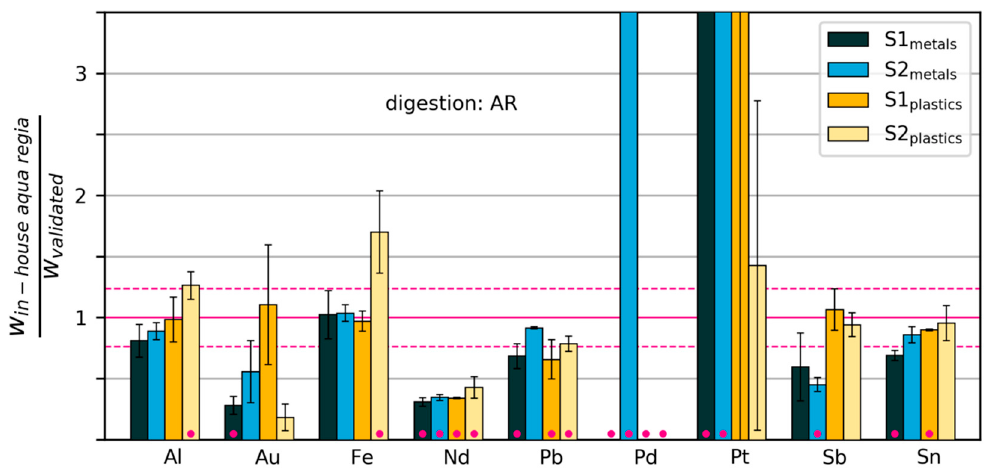
Figure 7. Mass fractions measured by “in-house” digestion in aqua regia, relative to mass fractions measured with the validated method. The dashed horizontal lines show the relative standard deviation of the validated measurements across all elements. Error bars extend one standard deviation above and below the mean (calculated from three repeated digestions / measurements). Pink dots indicate that the measurements were significantly di ff erent from those of the validated method ( p < 0.02). Some values are too large to be displayed within the limits of the y -axis (see Table